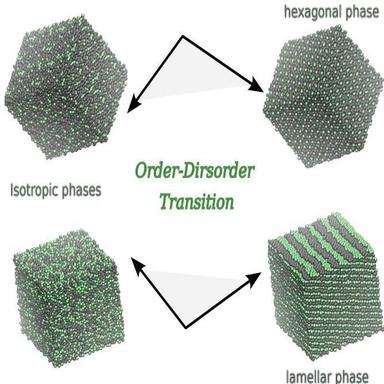
Ordered and disordered configurations were analyzed under different structural parameters for each type of system: hexagonal-isotropic system ( = 0.24) on top, and lamellar-isotropic system ( = 0.5) on the bottom. The gray beads represent the A particles, while the green beads represent the B particles.